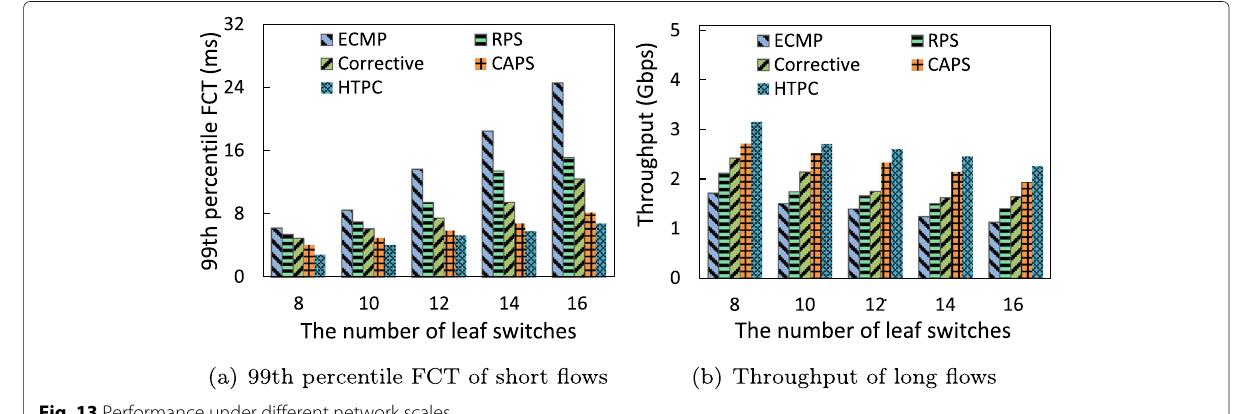
Fig. 13 Performance under different network